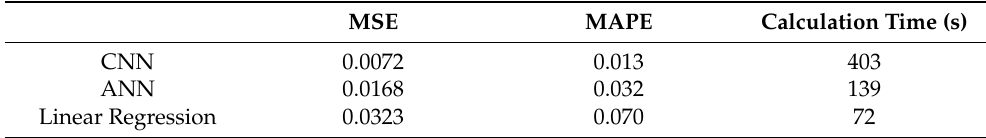
Table 5. Comparison of implemented CNN model, ANN, and linear